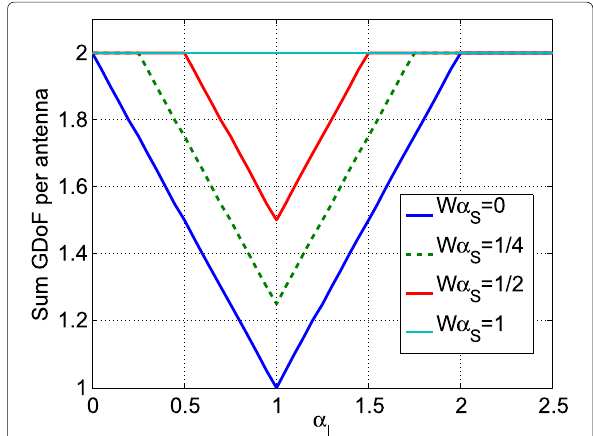
Fig. 5 The sum GDoF per antenna for M ul = N dl when BS has an excess of antennas